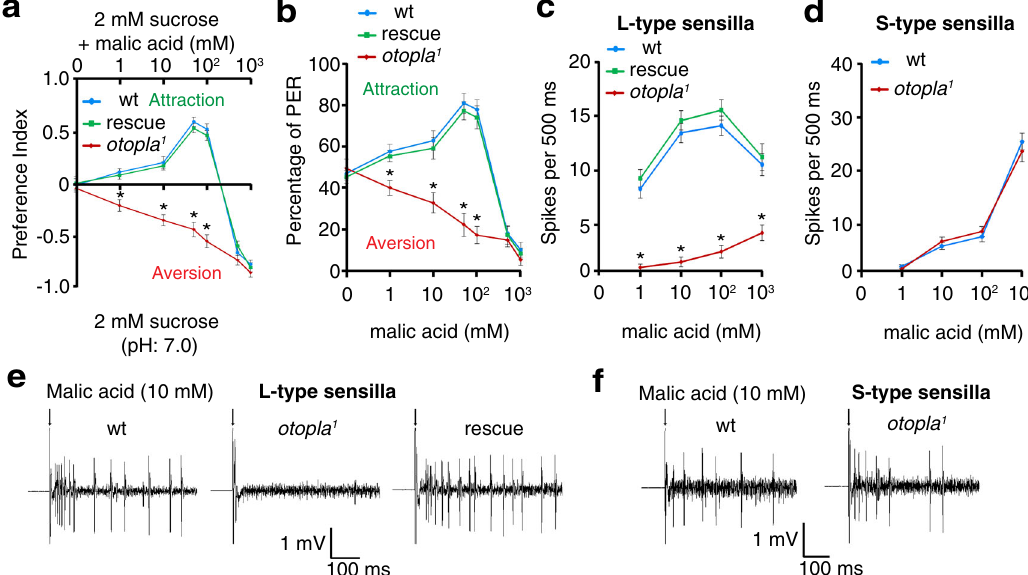
Fig. 4 Feeding and electrophysiological responses to low and high concentrations of malic acid among wild-type (wt), otopla 1 mutant, and rescue fl ies. a Feeding preference between neutral foods containing 2 mM sucrose and foods comprising 2 mM sucrose and malic acid (1 mM, pH 3.6; 10 mM, pH 3.2; 100 mM, pH 2.7; 1000 mM, pH 1.9). Data are presented as mean ± SEM. n = 10 trials, * p < 0.0001 (1 – 100 mM), one-way ANOVA tests. b PER responses to foods containing 30 mM sucrose and different concentrations of malic acid. Data are presented as mean ± SEM. n = 10 trials, * p = 0.0012 (1 mM), * p = 0.0004 (10 mM), and * p < 0.0001 (50 and 100 mM), one-way ANOVA tests. c , d Statistical analyses of spike frequencies evoked by varying concentrations of malic acid at the L6 sensilla ( c ; n = 10 animals (1 – 1000 mM), * p < 0.0001 (1 – 1000 mM), one-way ANOVA tests) and S5 sensilla ( d ; n = 10 animals for 1 and 10 mM, n = 8 animals for 100 mM, and n = 9 animals for 1000 mM). Data are presented as mean ± SEM. e , f Representative spike trains elicited by 10 mM malic acid at the L6 sensilla ( e ) and S5 sensilla ( f ). Arrows indicate the onset of taste